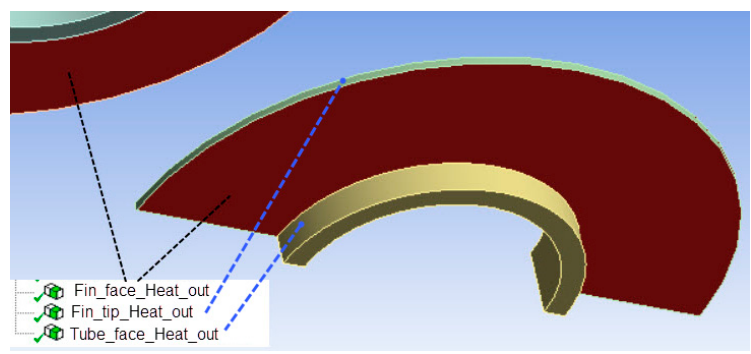
Figure 9. The named selection of fin.